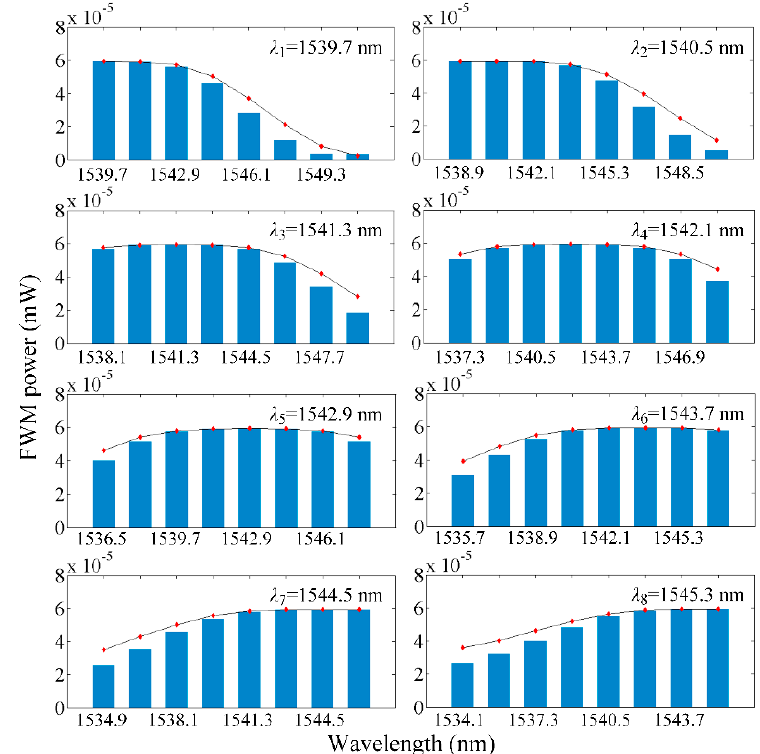
Figure 8. Newly generated FWM powers of eight optical wavelengths.